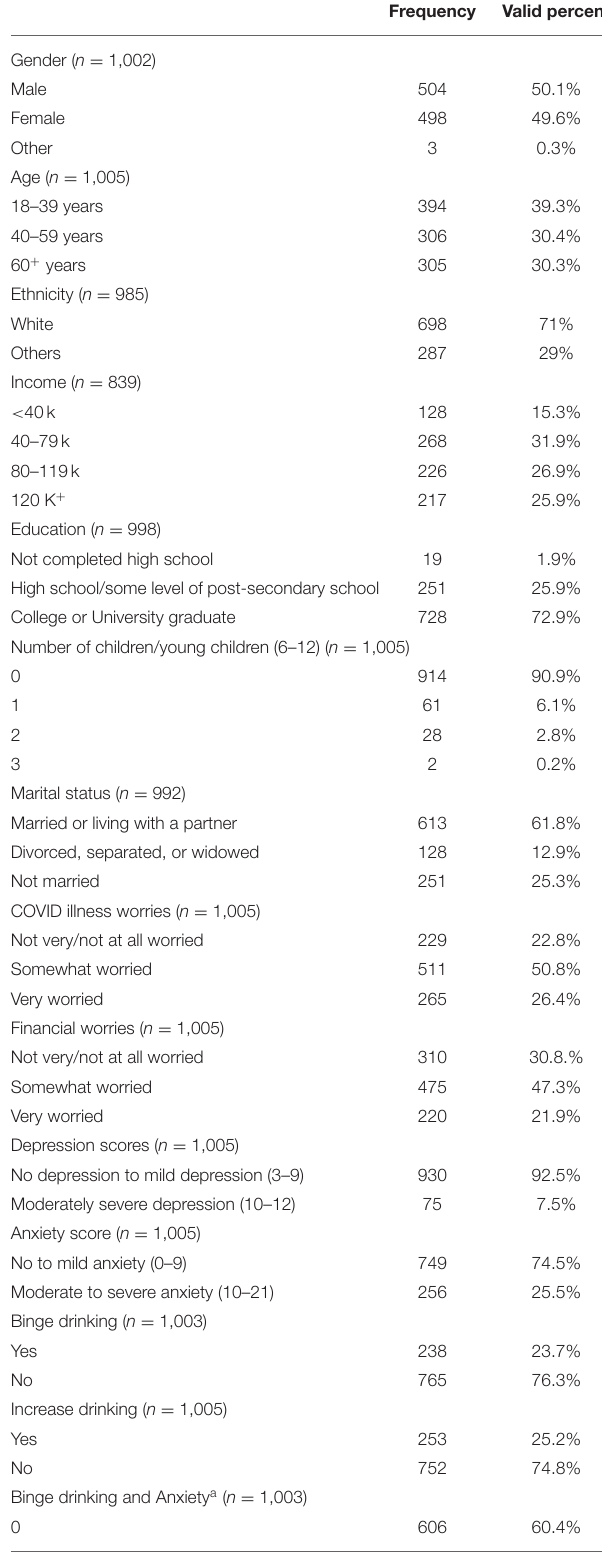
TABLE 1 | Descriptive characteristics of the study